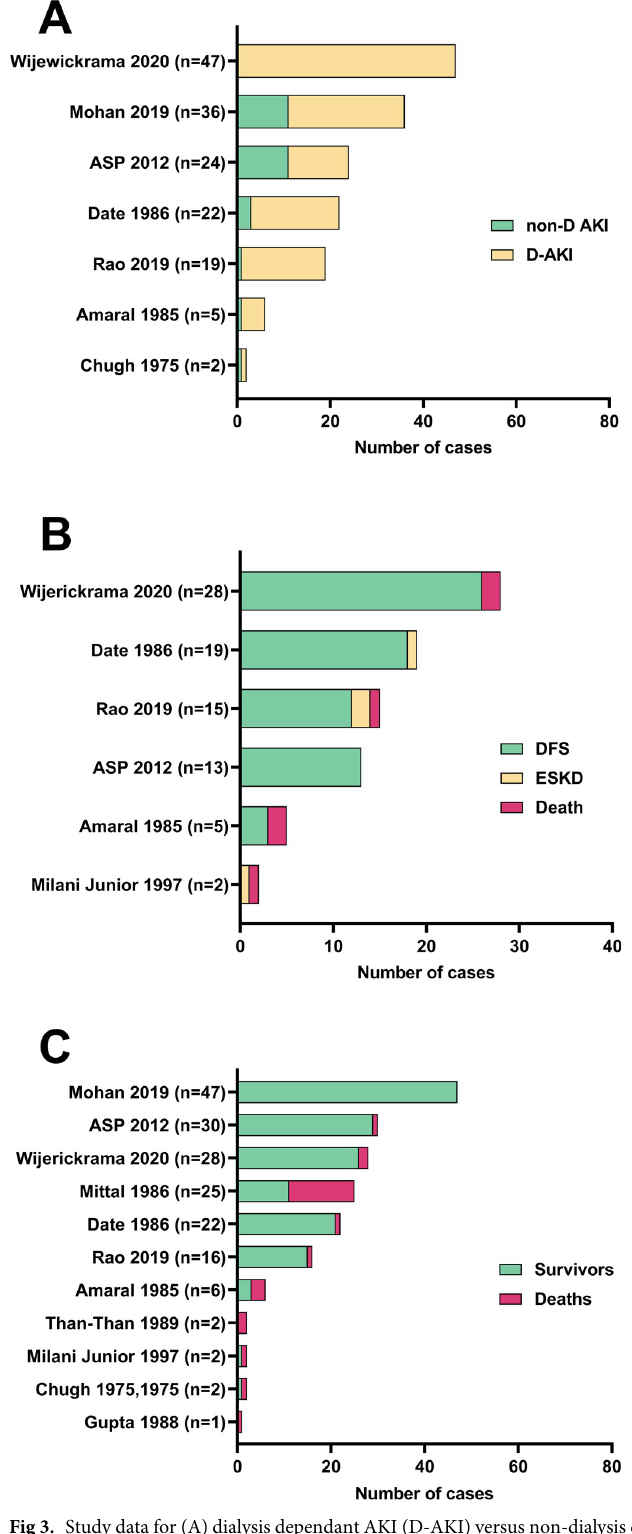
Fig 3. Study data for (A) dialysis dependant AKI (D-AKI) versus non-dialysis dependant AKI (non-D AKI); (B) dialysis free survival (DFS) for cases with dialysis dependant AKI; and (C) overall survival for all TMA cases for studies with low risk of selection bias. ESKD: End stage kidney